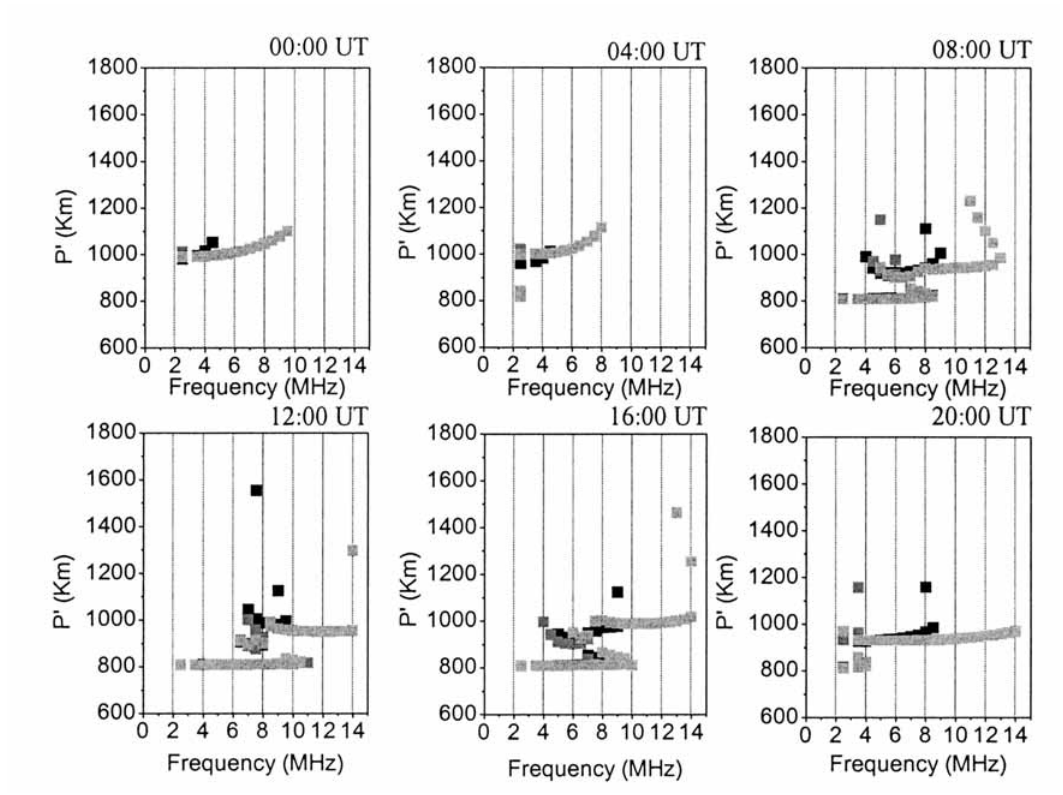
Fig. 2. Oblique ionograms obtained by abcray03 program corresponding to upper, lower and mean condi-